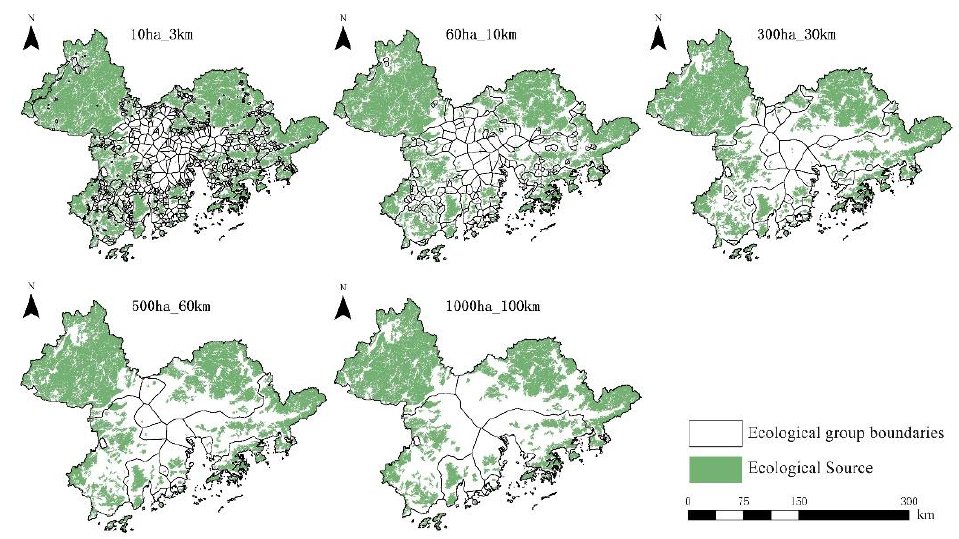
Figure 8. Five scattered scale ecological groups in the Guangdong–Hong Kong–Macao Greater Bay Area in 2020.